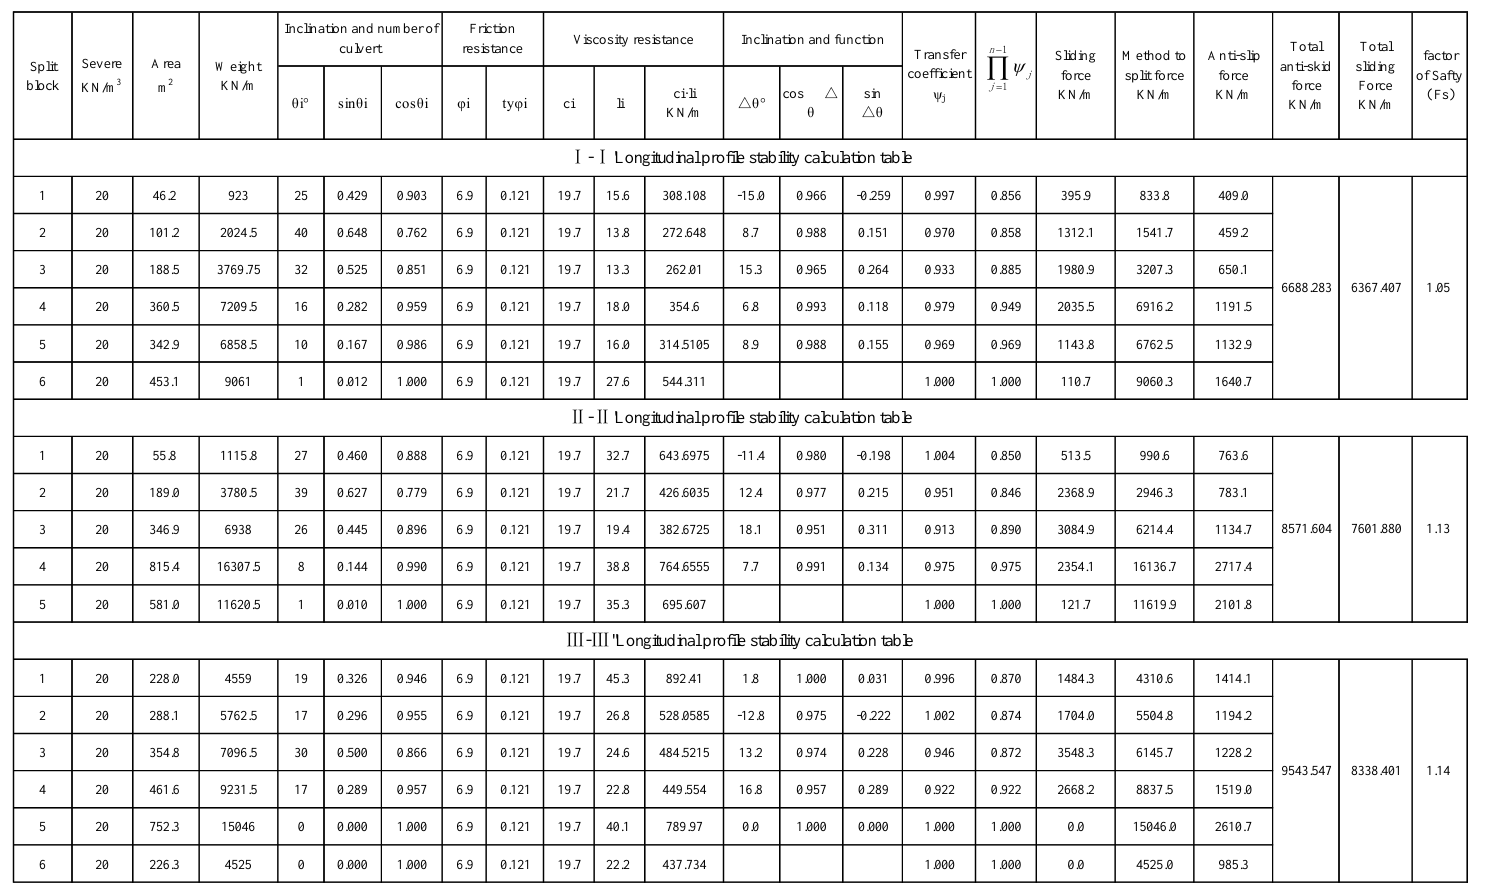
Figure A1. The calculation process of safety